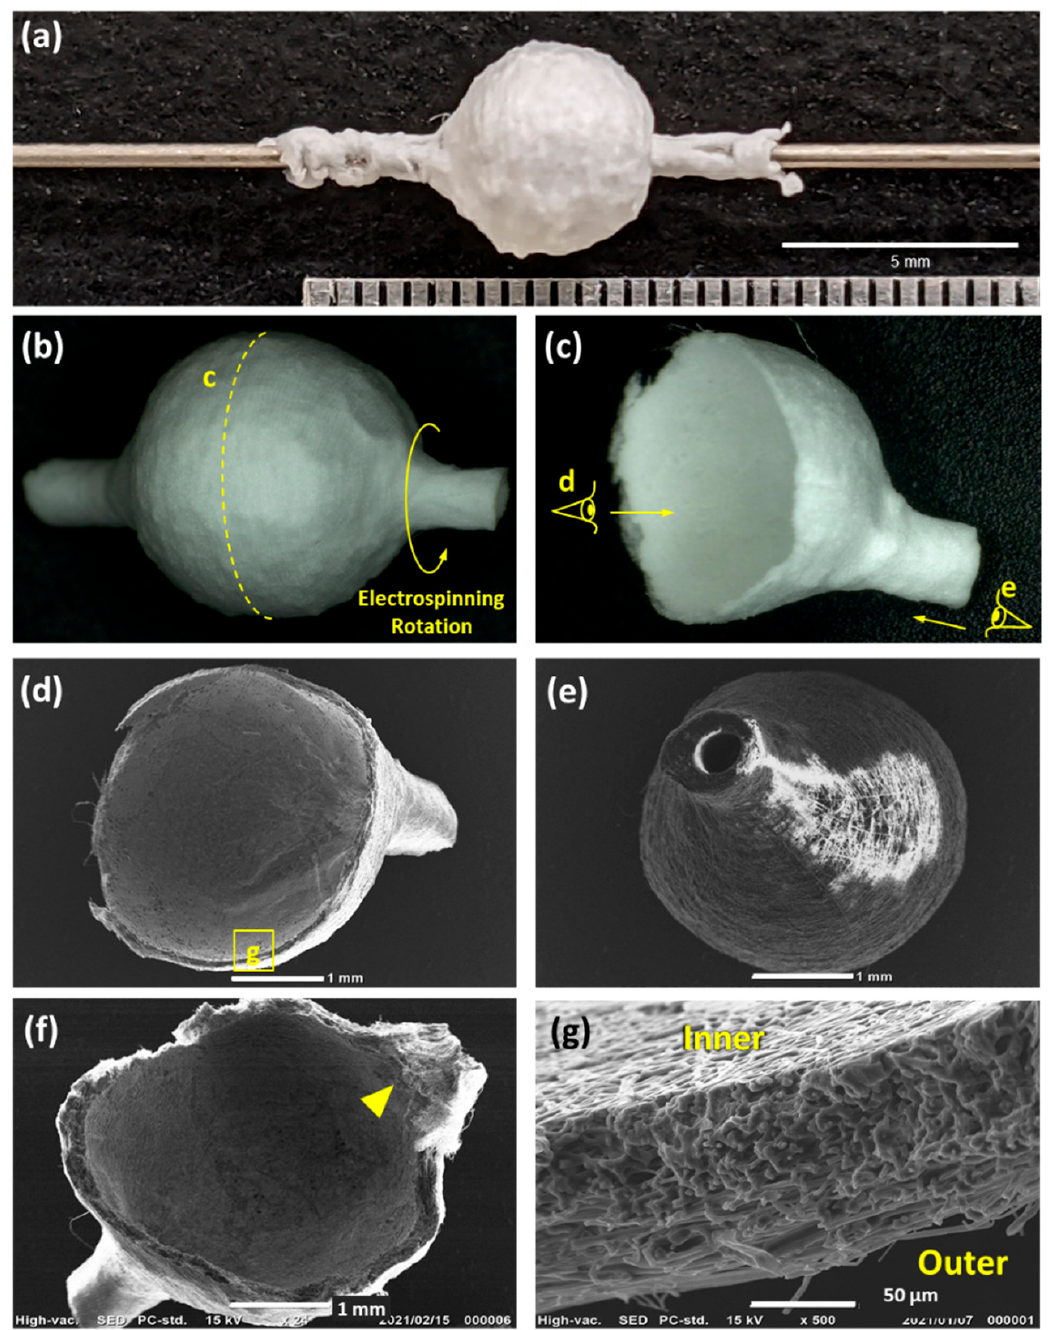
Figure 1. ( a ) Nanofiber-m â ch é ball electrospun on a wire. ( b ) Macroscopic pictures of overall structure and ( c ) nanofiber-m â ch é semi-sphere. ( d–g ) SEM images showing morphology of nanofiber-m â ch é ball. ( d ) Front view of semi-sphere, showing cup structure. ( e ) Back view of semi-sphere, showing a cell-seeding hole. ( f ) Longitudinal section of nanofiber-m â ch é ball and duct. (Arrowhead: interface between duct and central sphere.) ( g ) High-magnification cross-sectional view of nanofiber-m â ch é ball. The different fiber geometries and degrees of alignment on the inner and outer surfaces was observed.